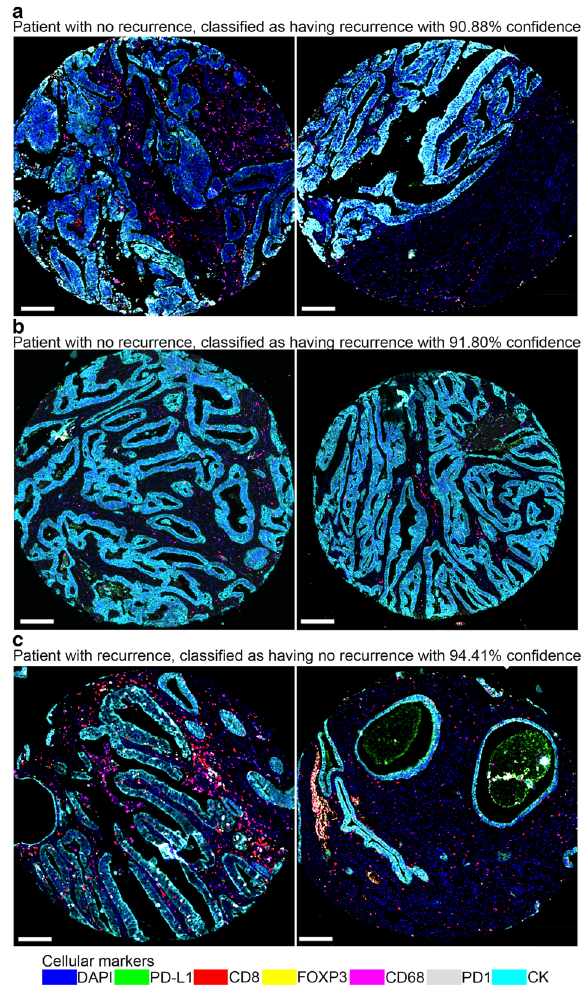
Fig. 9 Evaluation of challenging patients. a , b Only two patients with no recurrence were incorrectly classi fi ed as having recurrence (con fi dence predictions >0.90). They developed late endometrial cancer relapses after >7 years of relapse-free survival. Both patients were quanti fi ed as tissue area A1, indicating “ nonin fl amed ” or “ cold tumors ” . Visual interpretation of the tumor cores showed hetero- geneity within the tumor. c Patients with recurren c e that were incorrectly classi fi ed as having no recurrence (con fi dence prediction >0.90) showed tumor cores quanti fi ed as tissue area A3, indicating “ in fl amed ” or “ hot tumors ” . Visual interpretation of the tumor cores showed in fl ammation and distinct glandular architectural patterns. Scale bars, 50 μ